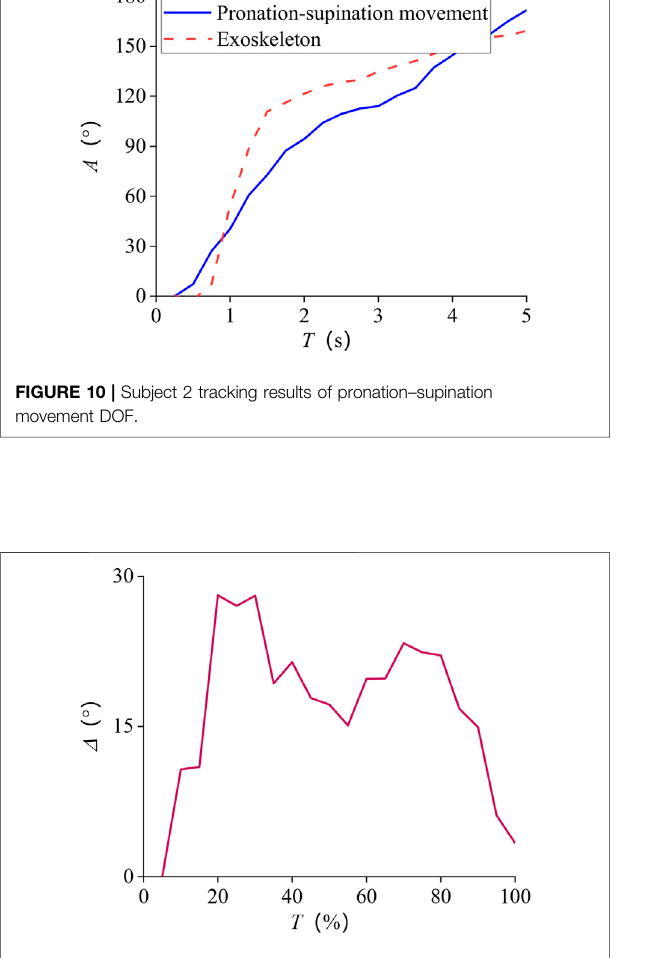
FIGURE 11 | Absolute error curve of pronation – supination movement DOF.